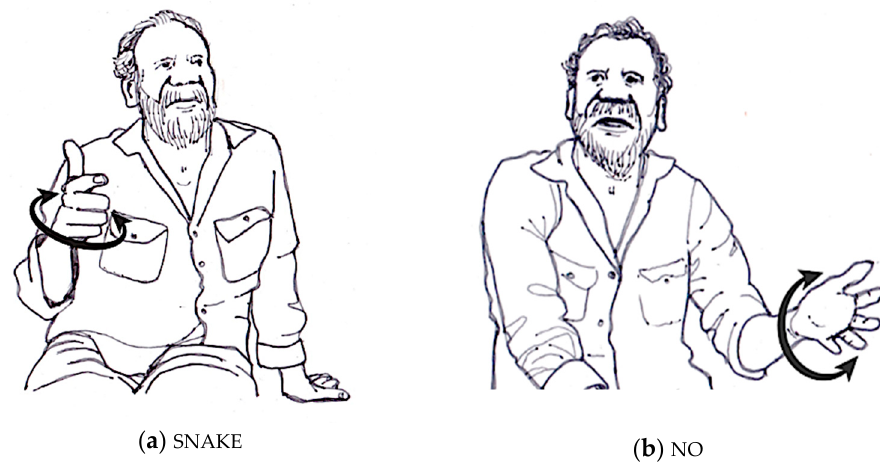
Figure 4. A Kukatja minimal pair for handshape ( a ) SNAKE ( b ) NO (Illustrations: Jennifer Taylor). Our Kukatja sign data contain only two compound signs. These signs use three handshapes which all appear in monomorphemic signs and so do not contribute any novel handshapes. One handshape—the j handshape—can be considered a borrowing from common gestural practices across Australia, as it is only used in the sign THREE .